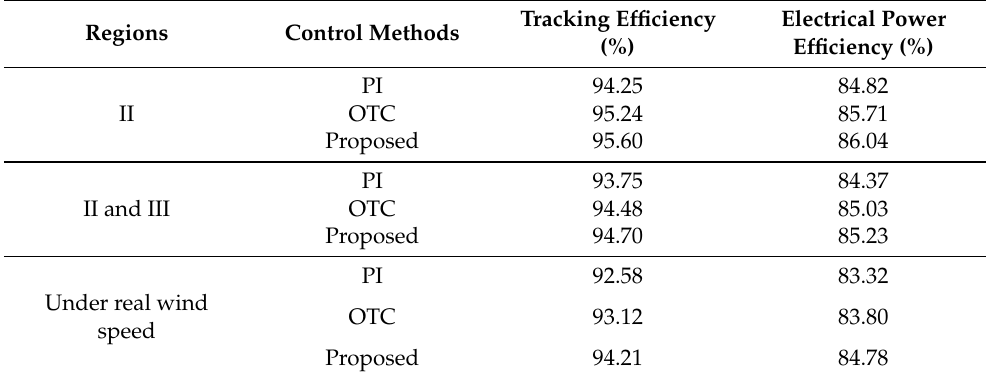
Table 2. PMVG rotor speed tracking performance and electrical power efficiency analysis from the simulation